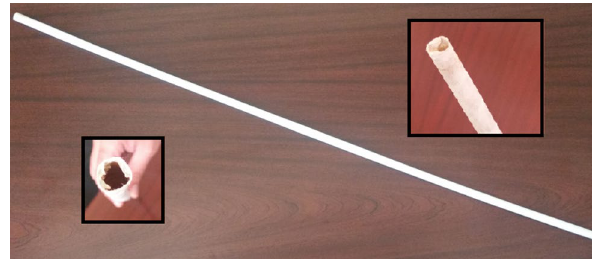
Fig. 6 Sample of the tubular membrane used in the membrane filtra- tion test unit; model: TR 14